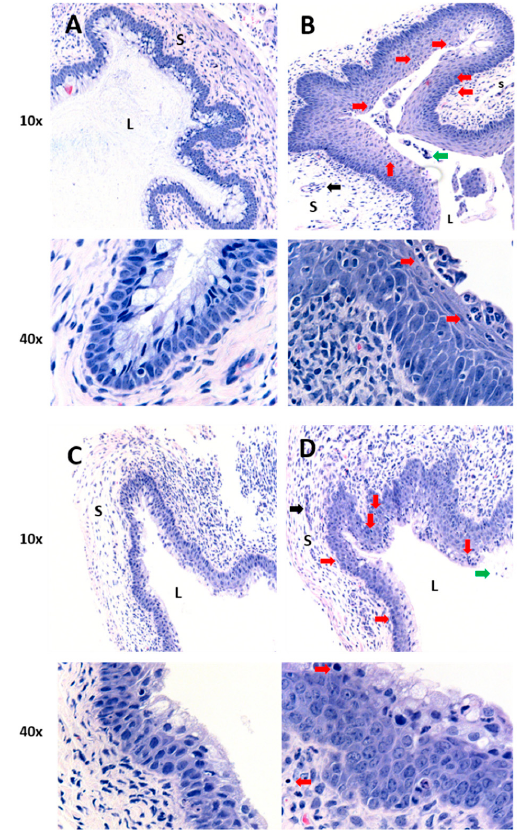
Figure 2. Histology of vaginal tissues from mice treated with curcumin nanoparticles by intravaginal delivery and challenged with CpG-ODN. All mice were depo-treated ( n = 3–4 per group). ( A ) Mice received water with no CpG-ODN (negative control). All other groups ( B – D ) received IVAG inoculation with 30 µg CpG-ODN 2 h after primary treatment with: ( B ) water (positive control), ( C ) 0.5 mg of curcumin in nanoparticles IVAG, or ( D ) vehicle-only nanoparticles IVAG. Images are representative from vaginal tissue of 1 animal per treatment group, with magnifications of 10 × and 40 × . L denotes vaginal lumen and S denotes the vagina submucosa. Red arrows indicate thickened vaginal epithelium and / or inflammatory cell infiltration in the epithelium and submucosal tissue. Black arrows indicate inflammatory cell infiltrates in the blood vessels. Green arrows indicate inflammatory cells in the luminal